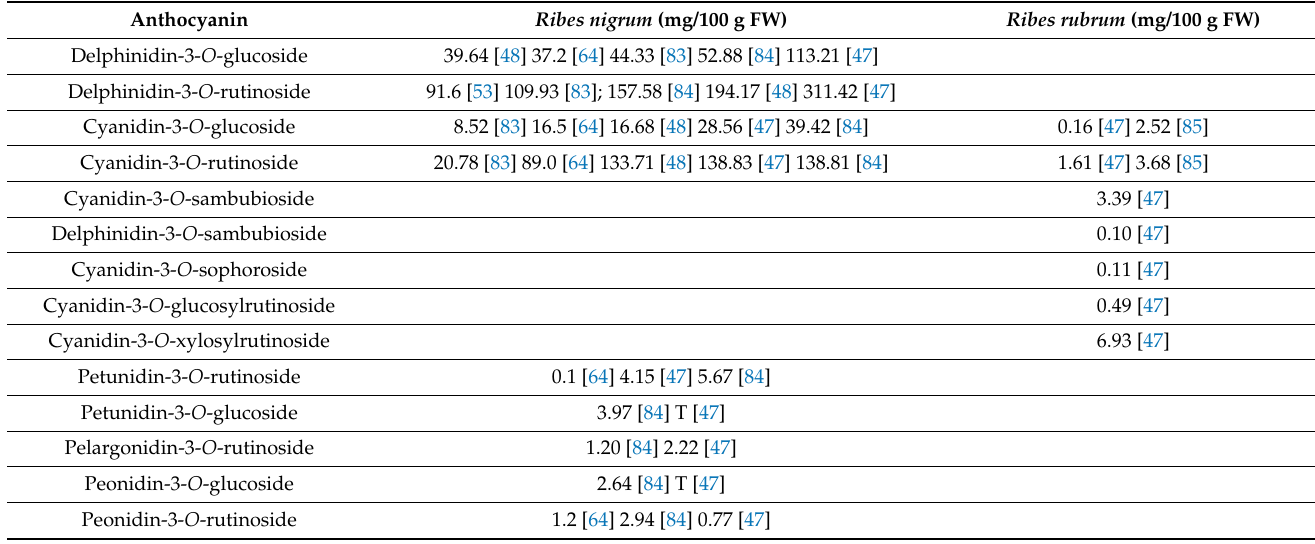
Table 6. Specific anthocyanin contents found in fruits from Grossulariaceae